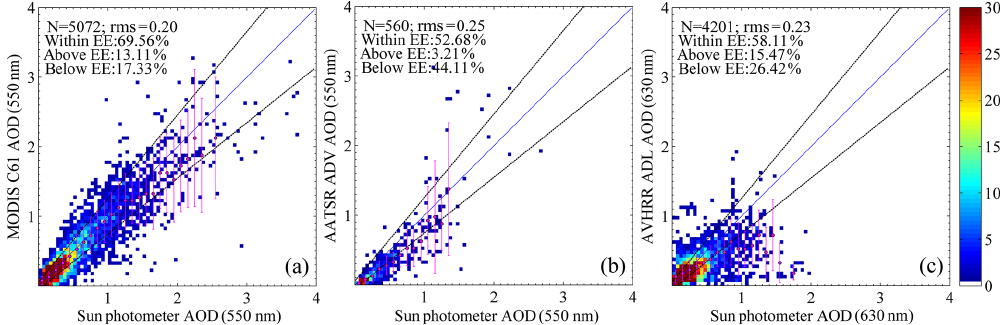
Figure 3. Scatter density plots of satellite-retrieved AOD vs. sun-photometer-retrieved AOD data from AERONET (all available data) and CARSNET (3 years: 2007, 2008 and 2010) stations in the study